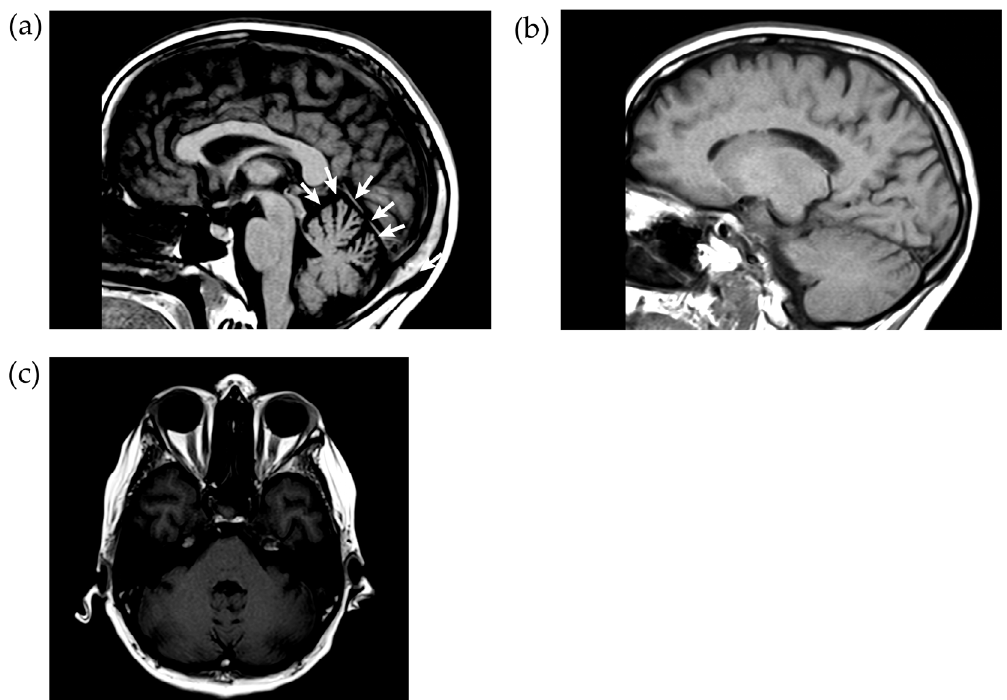
Figure 3. Sagittal 1.5 Tesla T1 weighted MRI scan made 1 month after hospital admission, showing ( a ) the anterior vermal atrophy in the mid-sagittal plane (arrows), ( b ) normal cerebellar hemispheres in a more lateral plane (TE = 8.7 ms; TR = 400 ms), and ( c ) a horizontal section showing that the cerebellar hemispheres are intact (TE = 8.7 ms; TR = 510 ms).